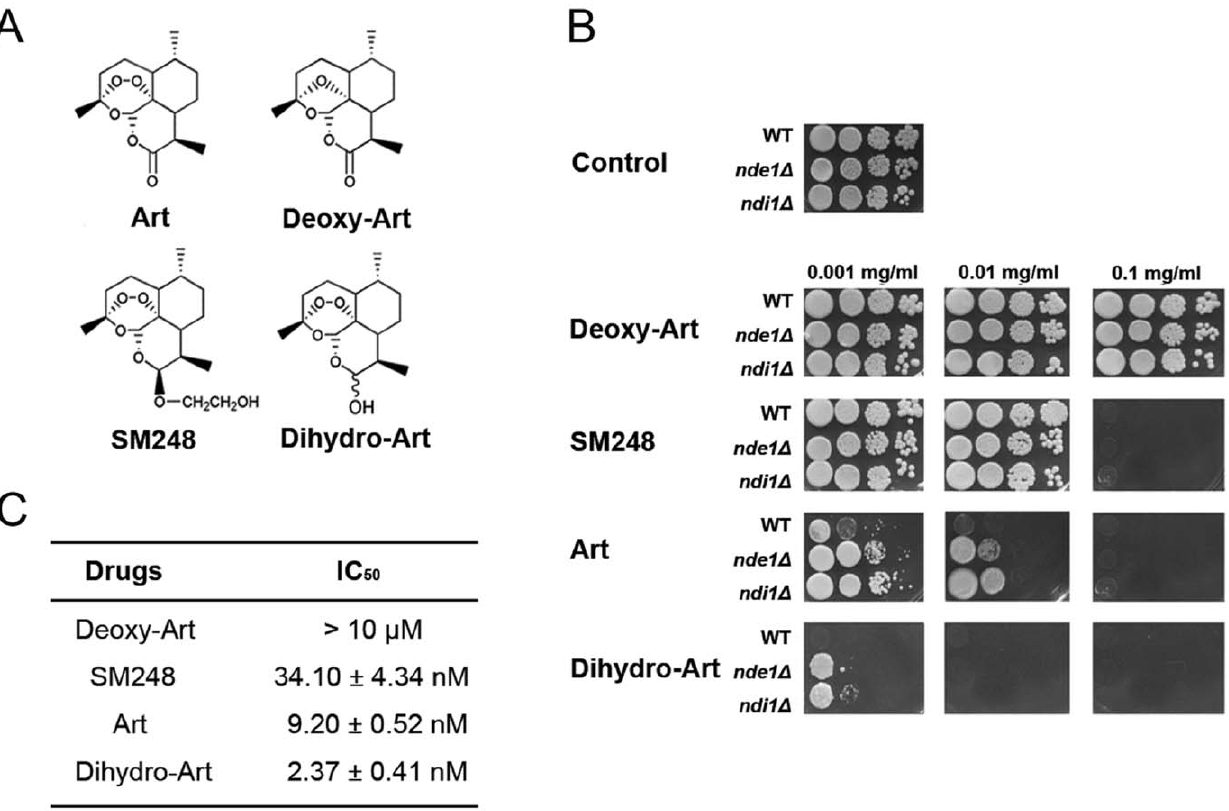
Figure 2. The peroxidic bridge is essential to the inhibitory activity of artemisinin in both yeast and malaria parasites. (A) Molecular structures of artemisinin and analogues (artemisinins) used in the study. Deoxyartemisinin contains only one O in the otherwise O-O bridge. (B) Inhibition of yeast growth with artemisinins. Strains of ndi1 D and nde1 D , with mutated internal and external NADH dehydrogenase (type II complex I) respectively, exhibit reduced sensitivity to artemisinins. (C) Inhibition of P. falciparum growth by artemisinins in cell culture. Data were shown as mean 6 SEM.